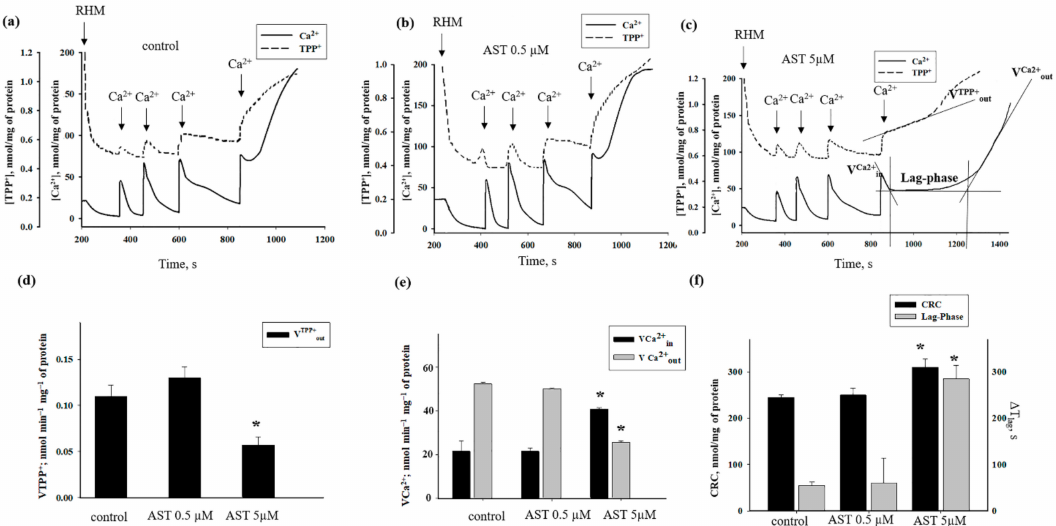
Figure 2. The e ff ects of AST on Ca 2 + transport, membrane potential, and CRC in RHM. Before being added to chamber, RHM were incubated with AST for 10 min. Before the addition of Ca 2 + , mitochondria were incubated with AST for 3 min in chamber. ( a ) Ca 2 + transport and membrane potential changes in RHM in control; ( b ) Ca 2 + transport and membrane potential changes in RHM in the presence of 0.5 µ M AST; ( c ) Ca 2 + transport and change of membrane potential in RHM in the presence of 0.5 µ M AST; ( d ) quantitative analysis of V TPP + out ; ( e ) quantitative analysis of V Ca2 + in and V Ca2 + out in RHM; ( f ) quantitative analysis of CRC and lag-phase. Data are presented as means ± SDs of five independent experiments. * p < 0.05 compared with control (without